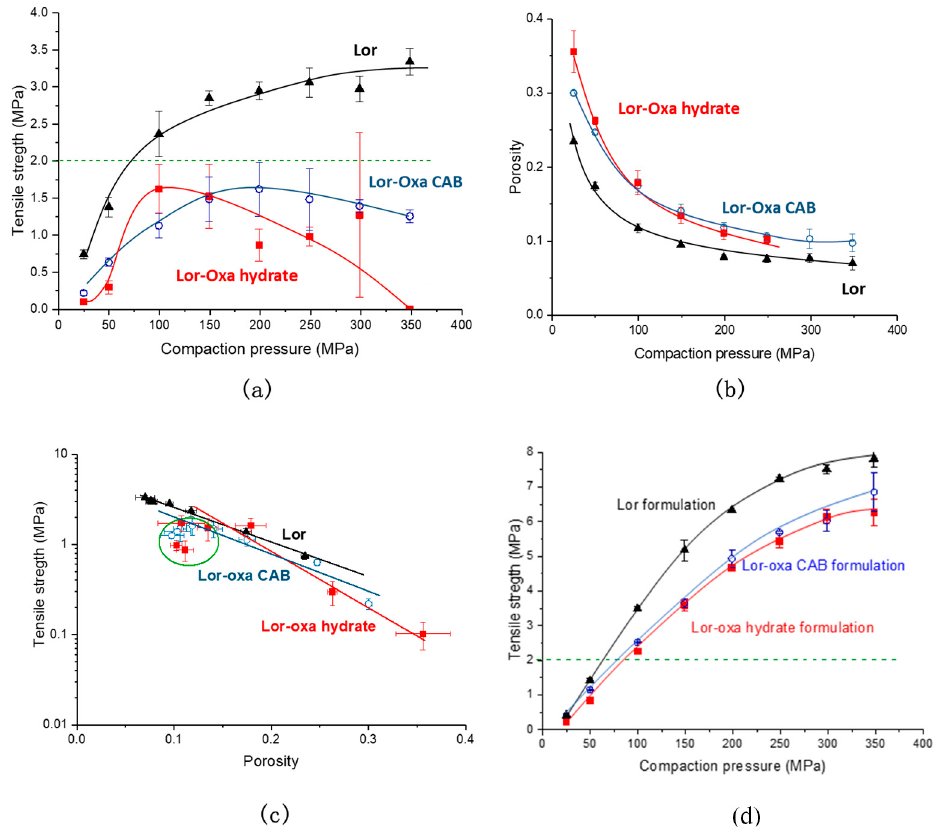
Figure 10. ( a ) Tabletability, ( b ) compressibility, and ( c ) compactibility profiles of pure Lor, Lor-Oxa CAB, and Lor-Oxa hydrate. ( d ) Tabletability profiles of formulations of Lor, Lor-Oxa CAB, and Lor-Oxa hydrate with 75% ( w / w ) MCC.